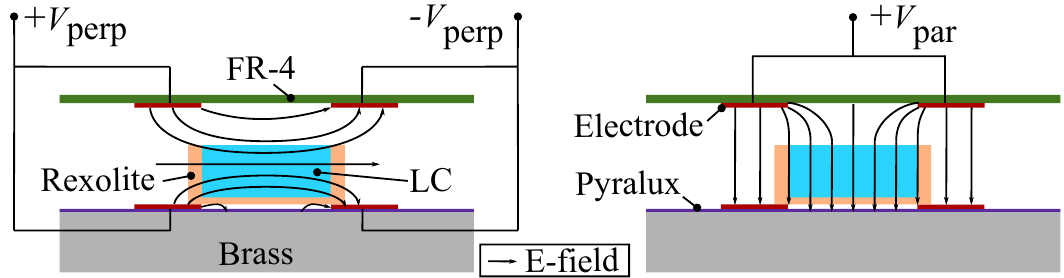
Figure 14. Cross section of the DIL phase shifter [23]. On the left and right side the bias configuration for orthogonal and parallel orientation is shown, respectively.